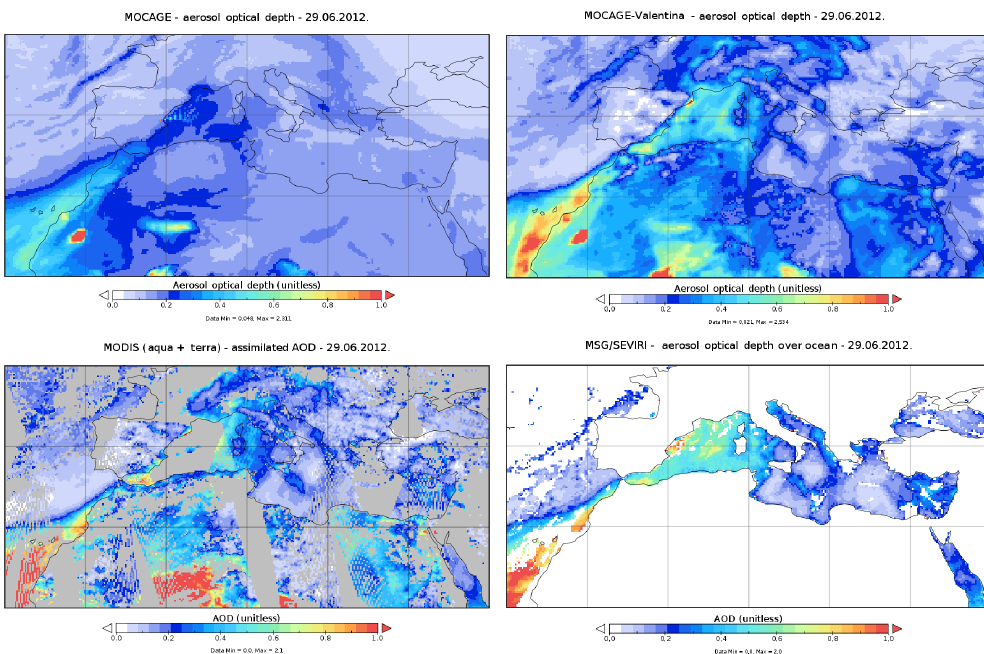
Figure 2. The aerosol optical depth over Europe on 29 June 2012 at 12:00UT, (top left) simulated in MOCAGE by the model direct run; (top right) simulated in MOCAGE by the MODIS assimilation model run; (bottom left) observed by MODIS (Aqua + Terra) and used for assimilation in MOCAGE (shown observations are collected during the whole day, and not only at 12:00); and (bottom right) observed by SEVIRI, which serves as an independent dataset. The colours from white to red represent AOD from low to high values.